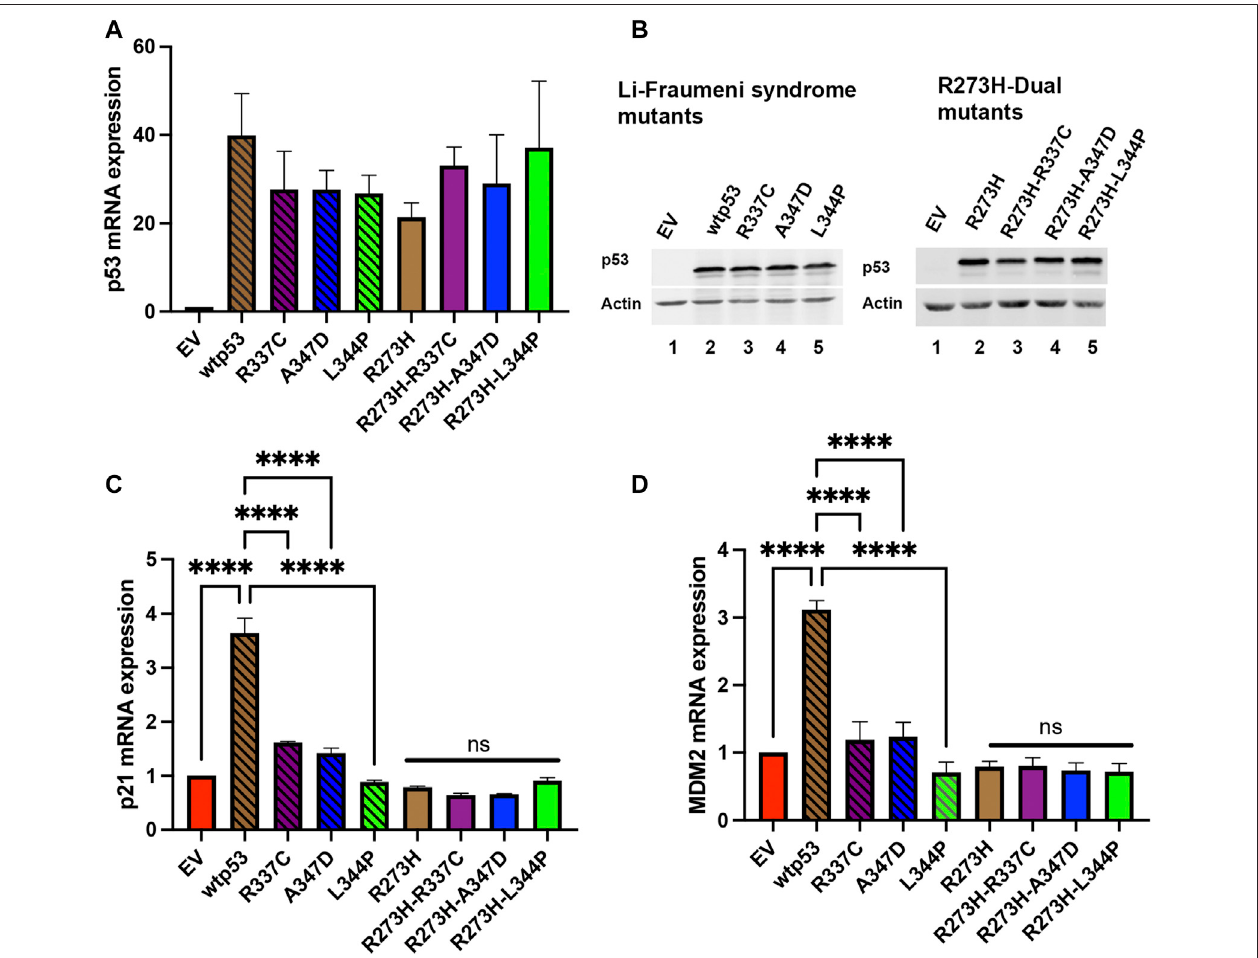
FIGURE 2 | Both p21 and MDM2 are activated by wtp53 but not mtp53. HCT116 p53 − / − cells transfected with plasmids expressing wtp53, or single mutants R337C,A347DorL344P;ormtp53R273H,ordualmutantsR273H-R337C,R273H-A347D,orR273H-L344Pwereharvested24 hpost-transfection.Thepelletswere dividedintotwoandusedforeitherproteinorRNAextraction.RNAwasextractedfrompelletand5 μ gofRNAusedforcDNAsynthesis.TheTaqManreal-timePCRwas used to measure the mRNA expression levels of p53 (A) , p21 (C) and MDM2 (D) target genes using GAPDH as endogenous control. The data represent an average of three independent biological replicates. A one-way ANOVA was used to determine the statistical signi fi cance of the data. The following format was used to assignsigni fi cancebasedon p -value:****representsa p -value ≤ 0.0001andnsrepresentnon-signi fi cant. (B) PelletswerelysedinRIPAbufferand25 μ goflysateloaded on a 10% SDS-PAGE and probed with anti-p53 DO1 antibody. Actin was used as a normalizer. Data represent three independent biological replicates.